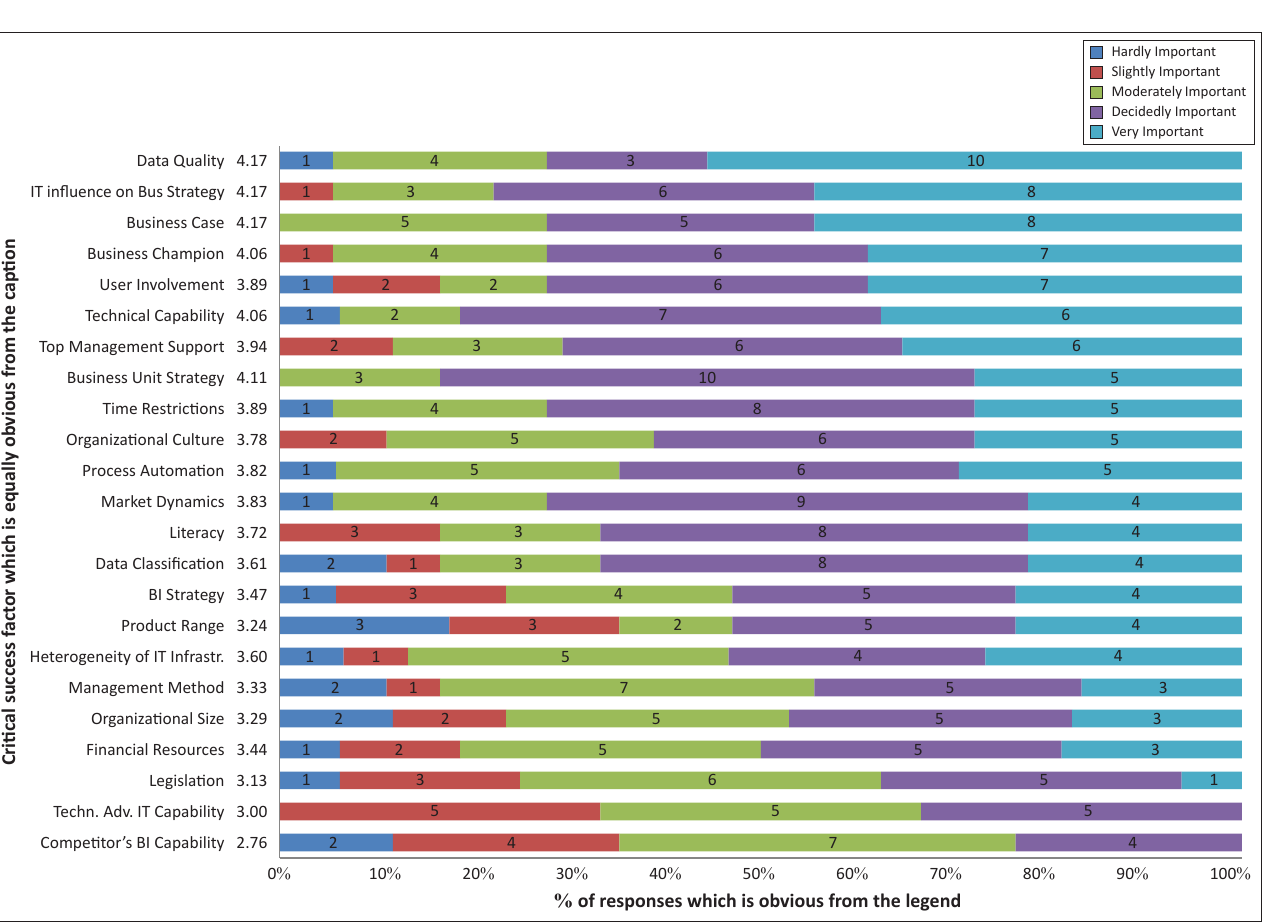
FIGURE 3: Importance ratings for each Critical Success Factor (round 2) by average and detailed